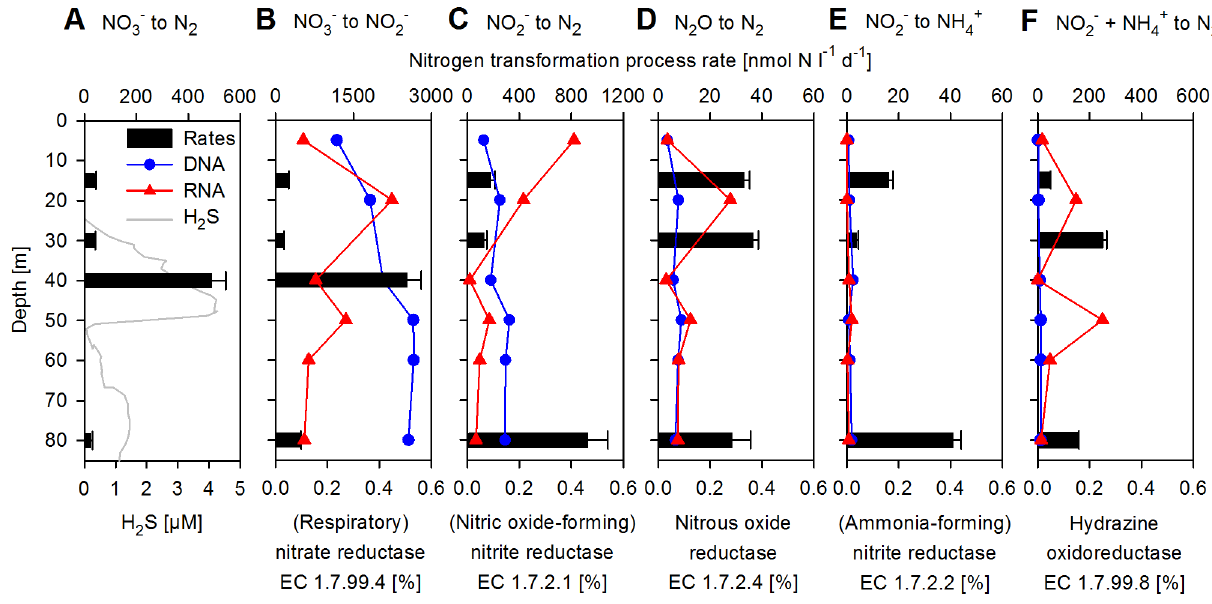
Figure 7. Vertical distribution of nitrogen transformation process rates and abundances of sequences encoding for involved enzymes. Shown in percent of all protein-coding DNA and RNA sequences, respectively. (A) NO 3 2 reduction to N 2 (denitrification). (B) NO 3 2 reduction to NO 2 2 , respiratory nitrate reductase (EC 1.7.99.4). (C) NO 2 2 reduction to N 2 , (NO forming) nitrite reductase (EC 1.7.2.1). (D) N 2 O reduction to N 2 , nitrous-oxide reductase (EC 1.7.2.4). (E) NO 2 2 reduction to NH 4 + (DNRA), (NH 4 + forming) nitrite reductase (EC 1.7.2.2). (F) NO 2 2 + NH 4 + to N 2 (anammox, based on the sole addition of NO 2 2 ), hydrazine oxidoreductase (EC 1.7.99.8). Please note that at 40 m only NO 3 2 reduction to N 2 (A) and NO 3 2 reduction to NO 2 2 (B) were measured.